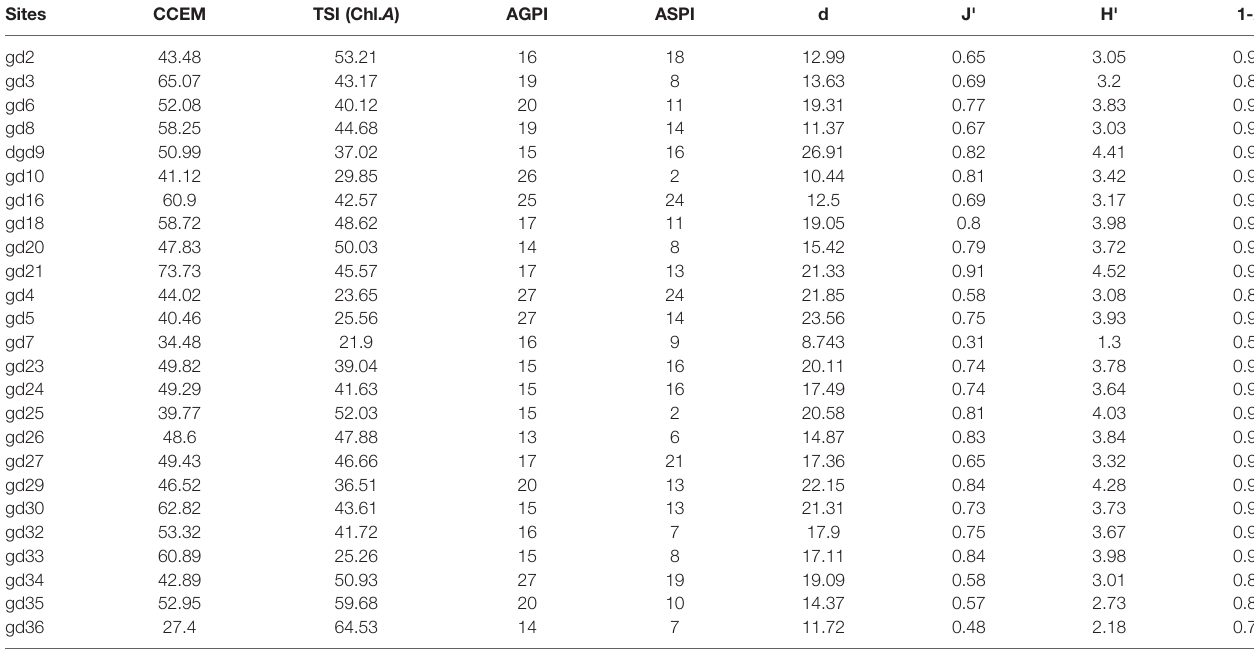
TABLE 5 | The calculated indices values during the dry season across the mangroves.